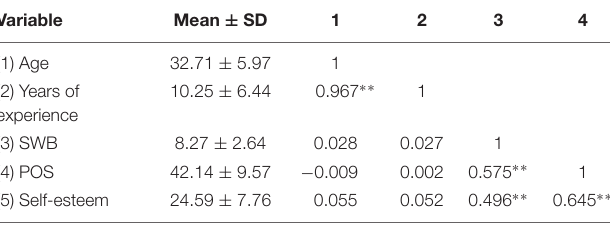
TABLE 2 | Correlations among continuous